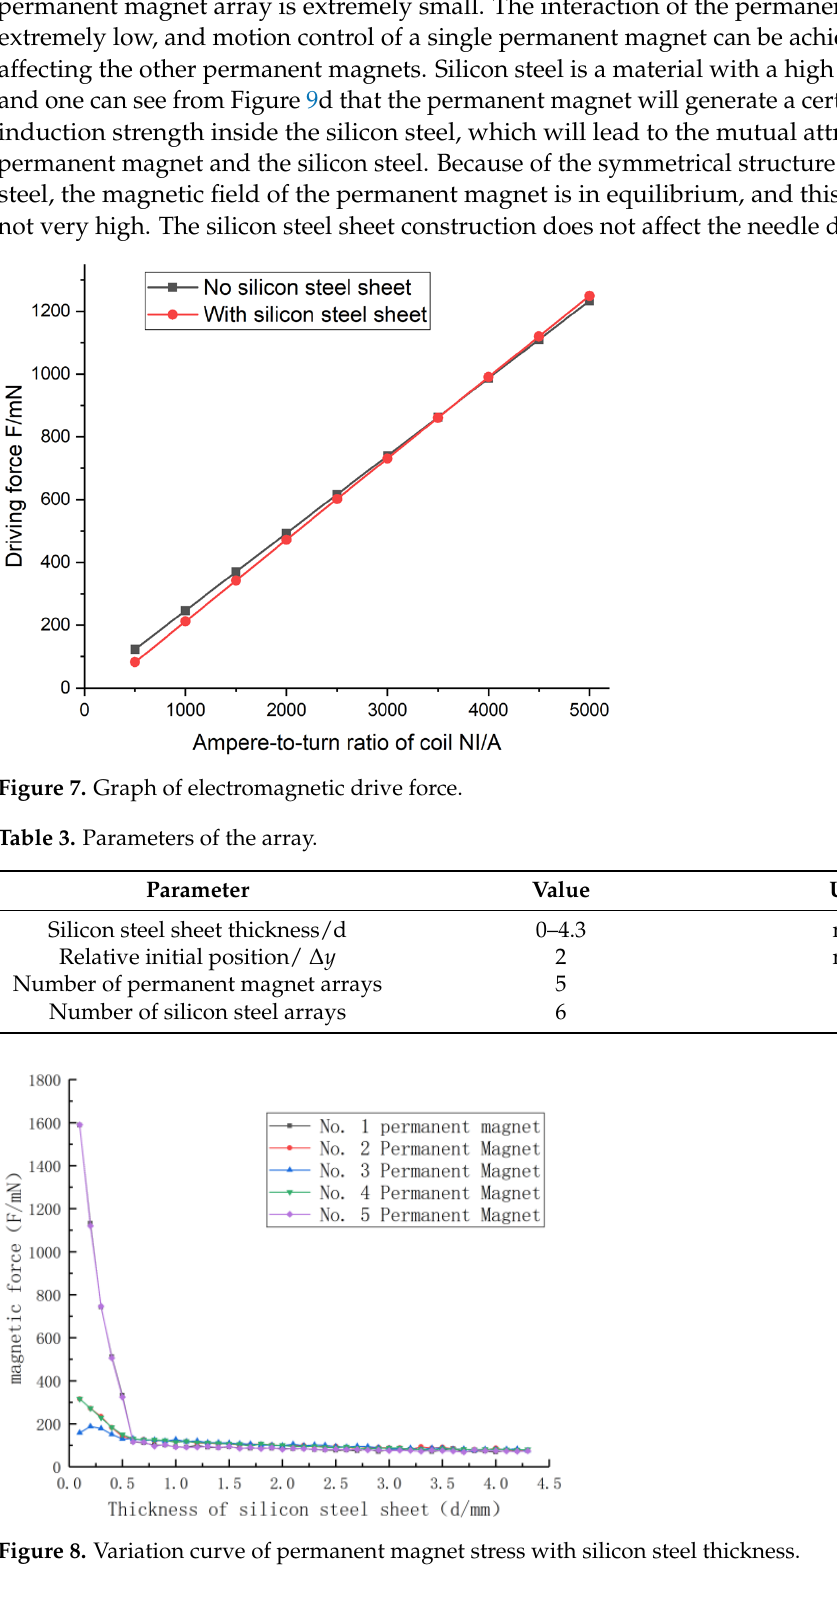
Figure 7. Graph of electromagnetic drive force.